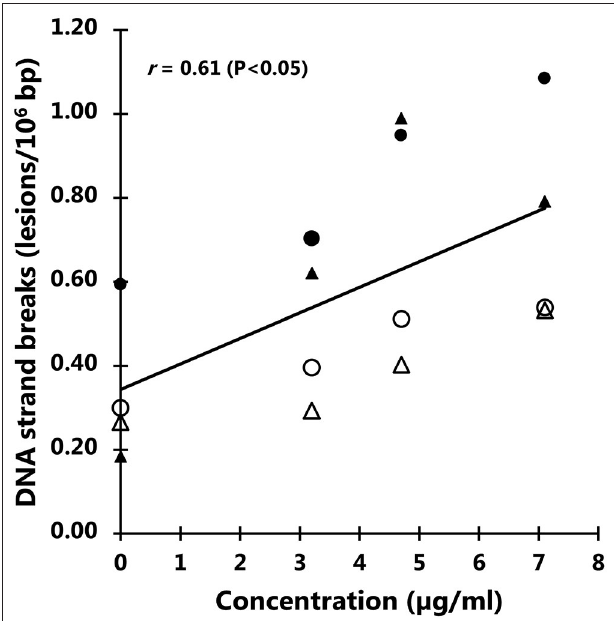
FIGURE 8 | Levels of DNA strand breaks in Caco-2 and HepG2 cells after 3h exposure to particles from black polyethylene terephthalate (PET) food containers. The correlation coefficient refers to the concentration response relationship in linear mixed effect model. Symbols are individual experiments. The positive control (100 µ M H 2 O 2 ) is 2.49 lesions/10 6 bp (standard error of the mean = 0.06 lesions/10 6